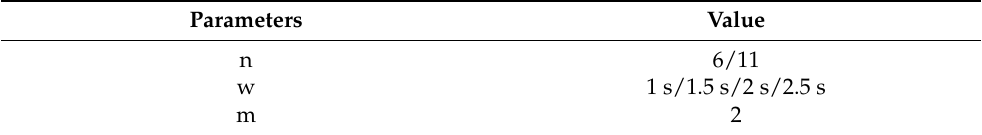
Table 3. The parameter configuration of the experiment.